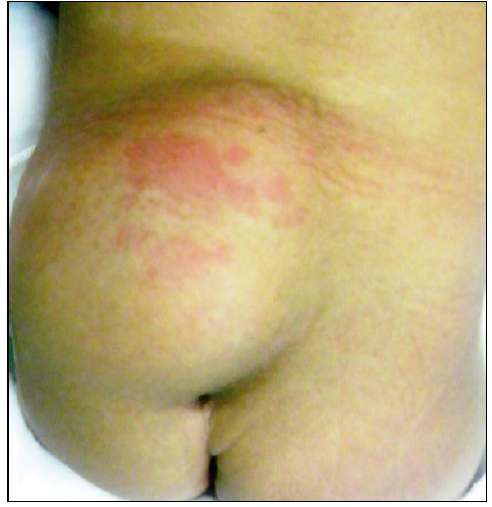
Figure 2: Note lipoma, cutaneous hemangioma, and atypical